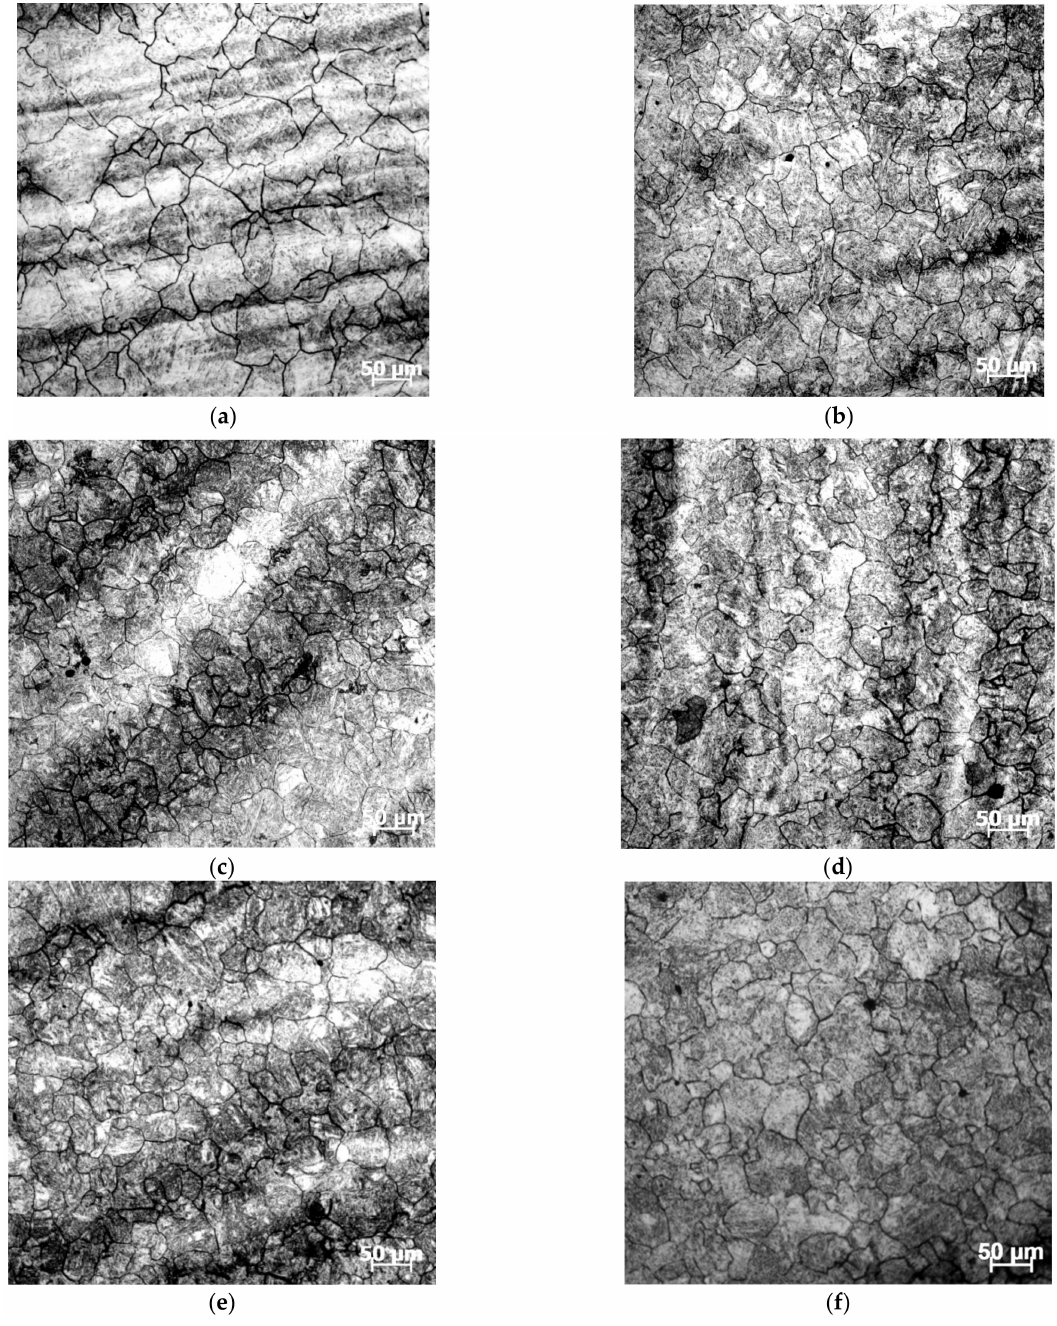
Figure 13. Optical microstructures of SAE 5137H steel at a constant temperature of 1303 K and strain rate of 0.1 s − 1 under deformation degree:( a ) 10%; ( b ) 20%; ( c ) 30%; ( d ) 40%; ( e ) 50%; ( f )